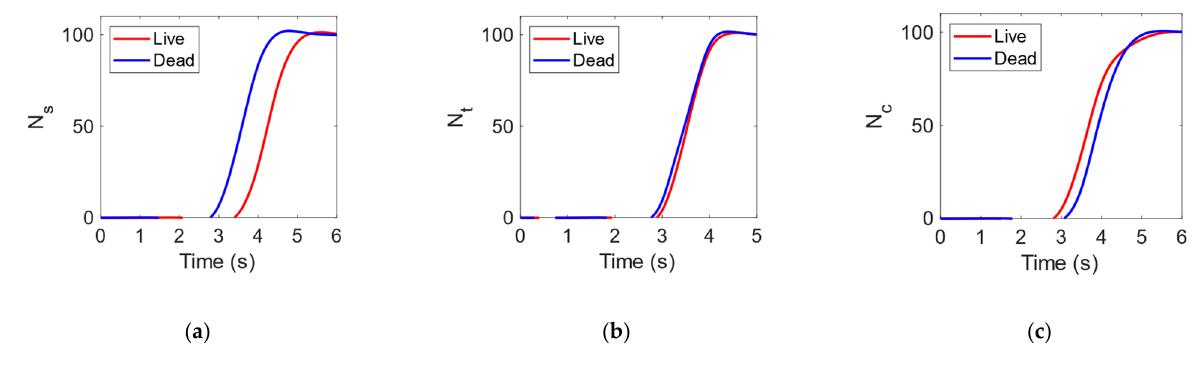
Figure 7. Number ( N ) of live (red) and dead (blue) E. coli at outlets #4 and #5. Time response for ( a ) squared ( V P = 3.2 V), ( b ) trapezoidal ( V P = 3.1 V) and ( c ) rounded ( V P = 0.5 V) con fi gurations at f = 2 MHz.